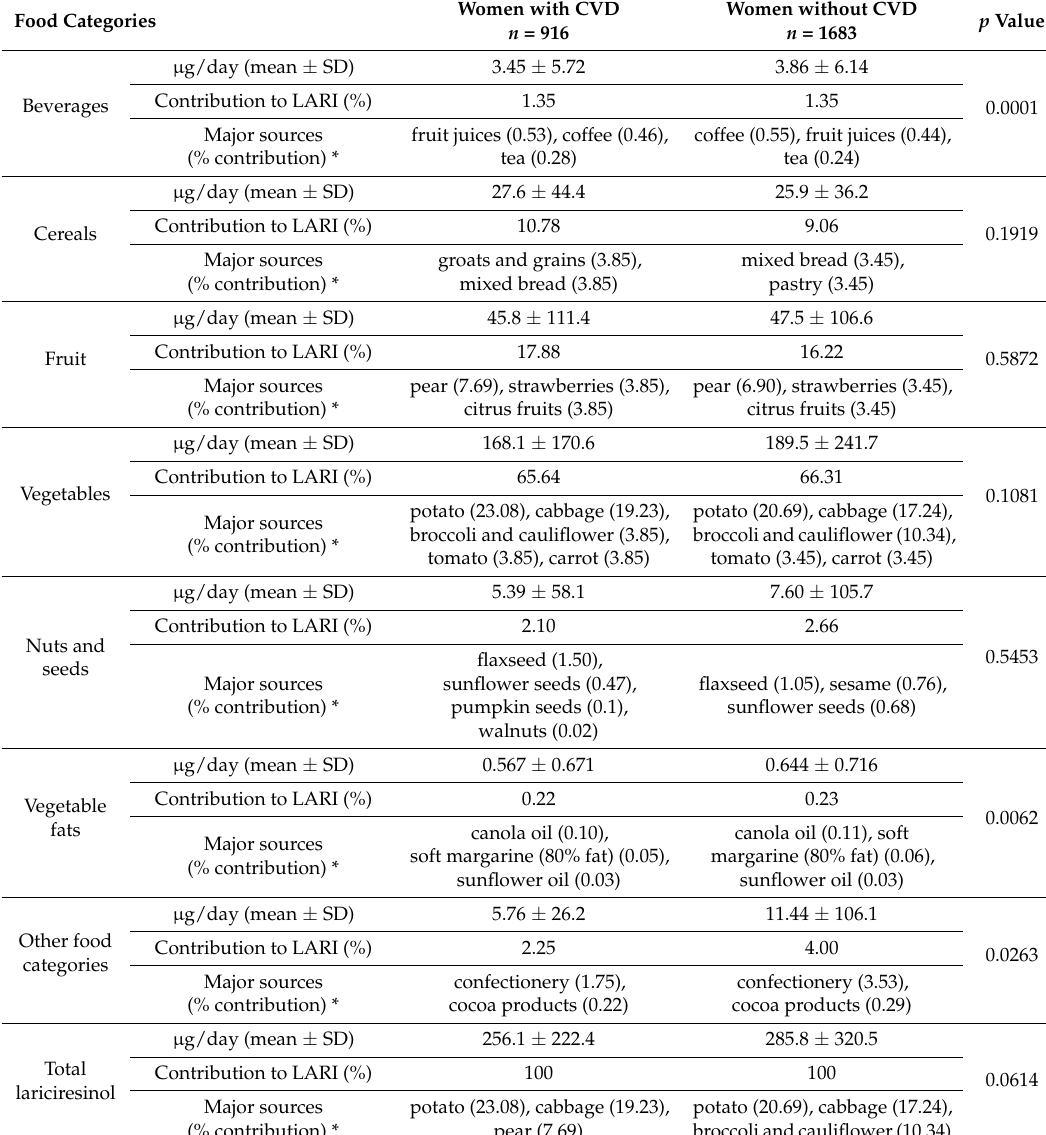
Table 5. Contributions of food categories and individual food products to lariciresinol (LARI) intake in women with and without